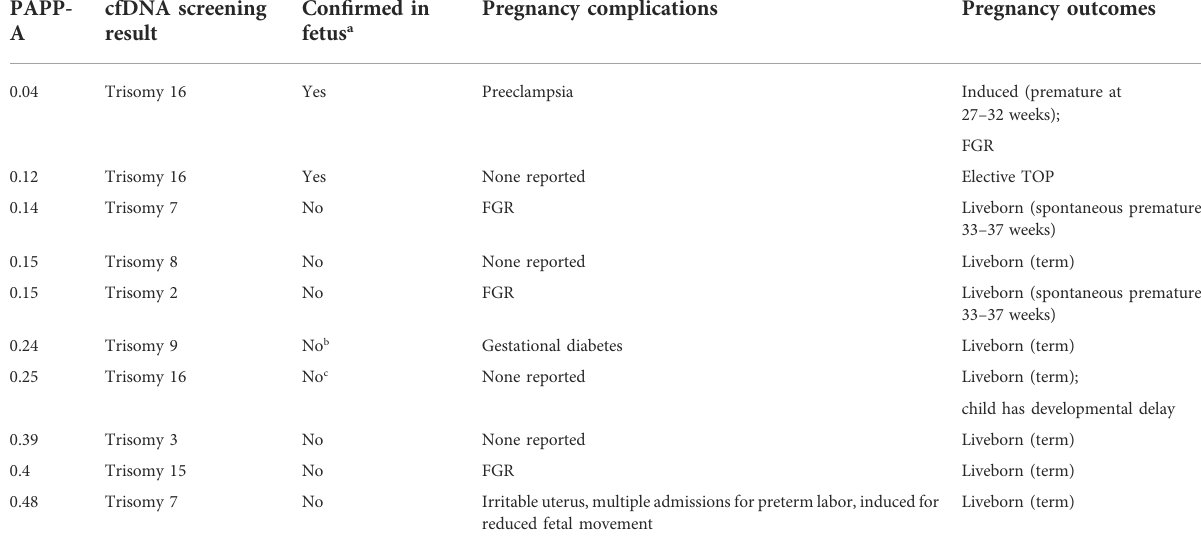
TABLE 3 Relationship between RAAs, low PAPP-A, and Pregnancy Outcomes. PAPP-